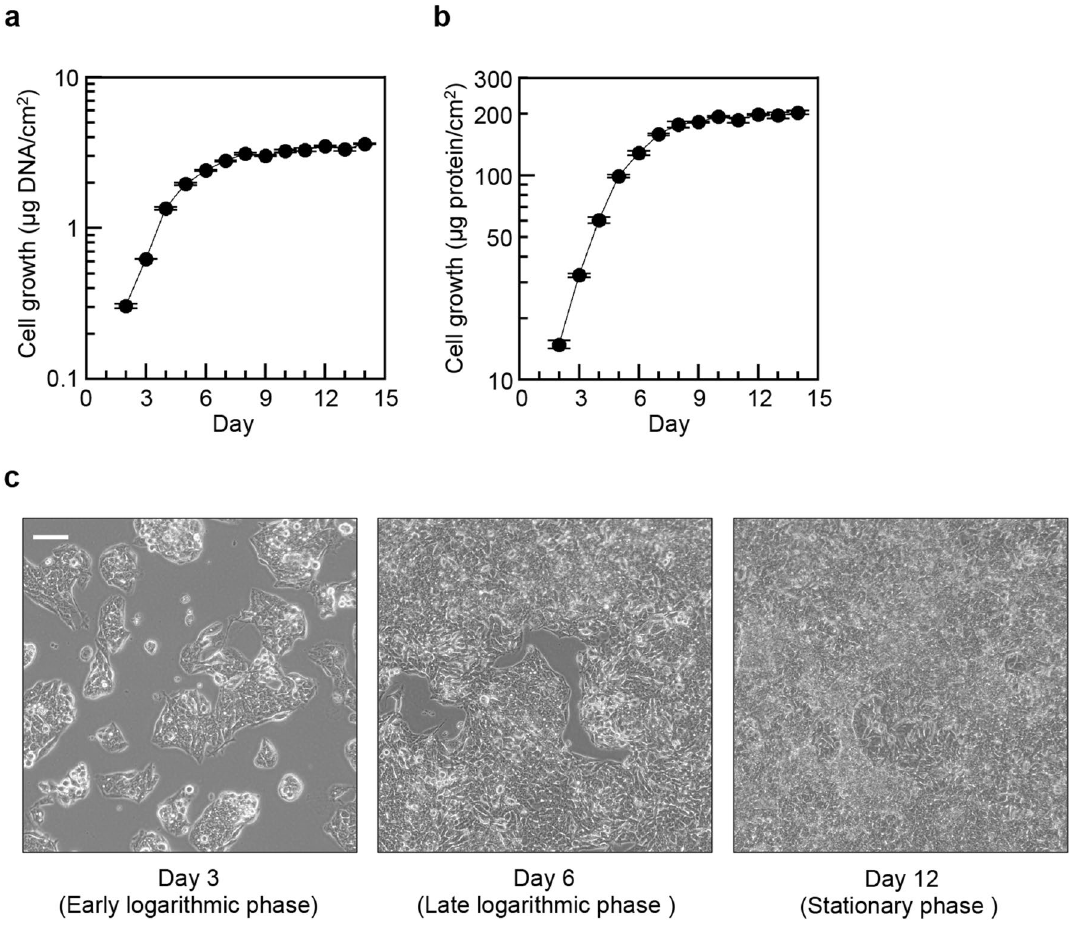
Figure 1. Cell growth of HepG2 cells. Cells were seeded at a density of 5.0 × 10 4 cells/cm 2 in six-well plates (Day 0). ( a , b ) Growth curves of HepG2 cells were determined by the measurement of total cellular DNA ( a ) and total cellular protein ( b ). Each point represents the mean value of three biologically independent experiments of duplicate measurements (mean ± S.E., n = 4). ( c ) Differential interference contrast images of HepG2 cells at Day 3 (early logarithmic phase), Day 6 (late logarithmic phase) and Day 12 (stationary phase). The scale bar represents 100